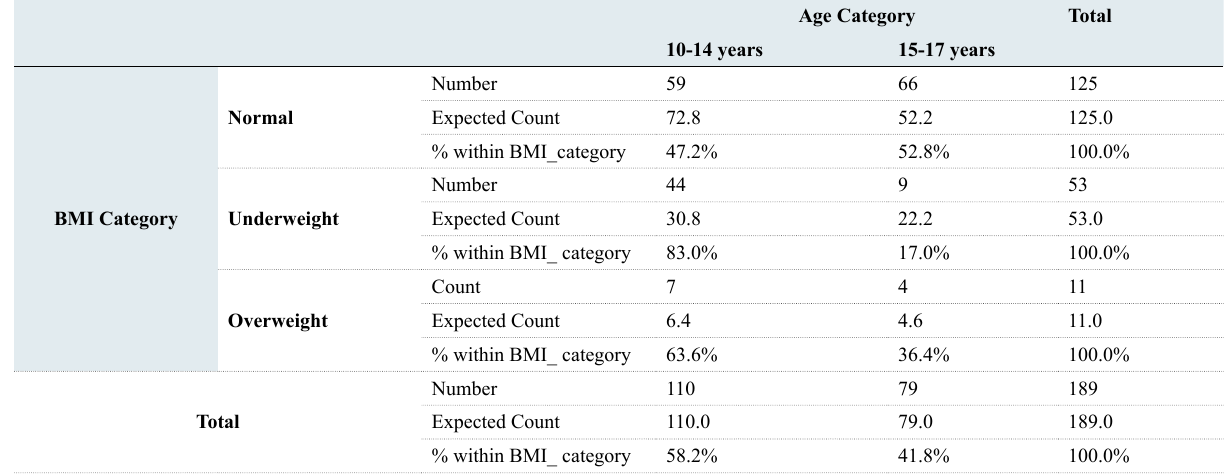
Table 2: BMI Category* Age Category Cross tabulation